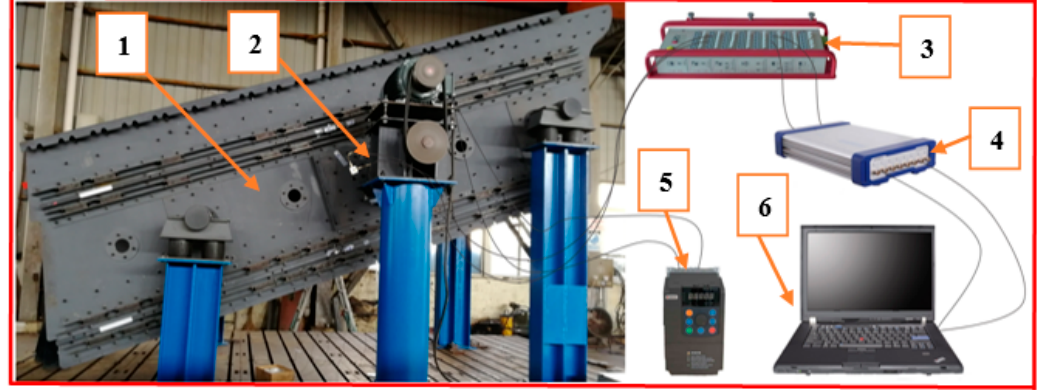
Figure 4. Test and analysis system diagram: 1. Double-deck vibrating flip-flow screen, 2. ICP acceleration sensors, 3. Multi-channel strain conditioner, 4. High-precision data acquisition instrument, 5. Frequency converter and 6. Computer.